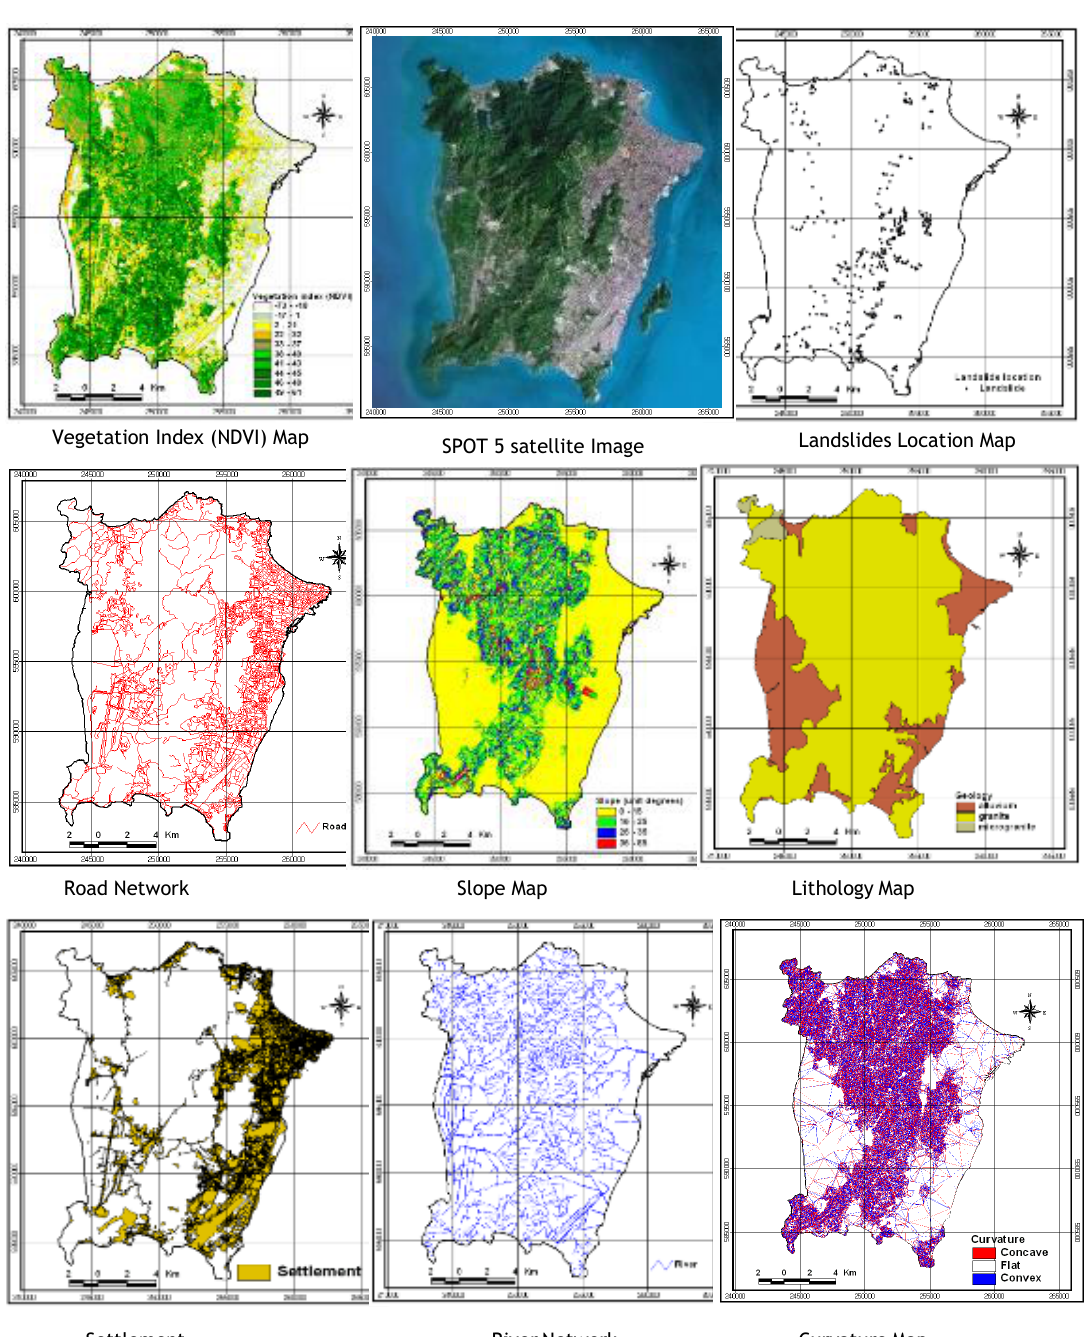
Figure 4. Spatial Data and Maps for the Landslide Disaster Modeling Stored in the